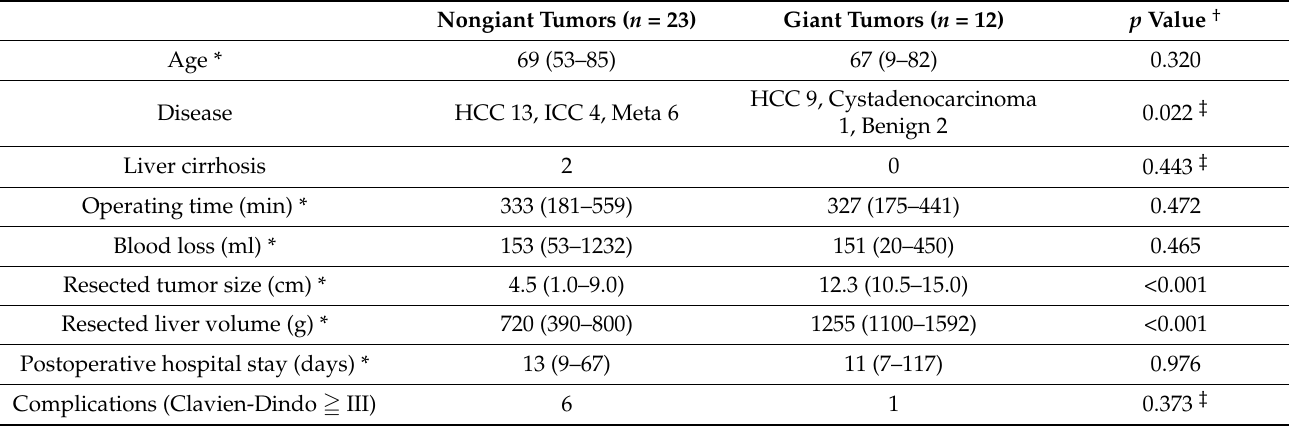
Table 3. Comparing the surgical outcomes for nongiant and giant liver tumors ( ≥ 10 cm) after laparoscopic right